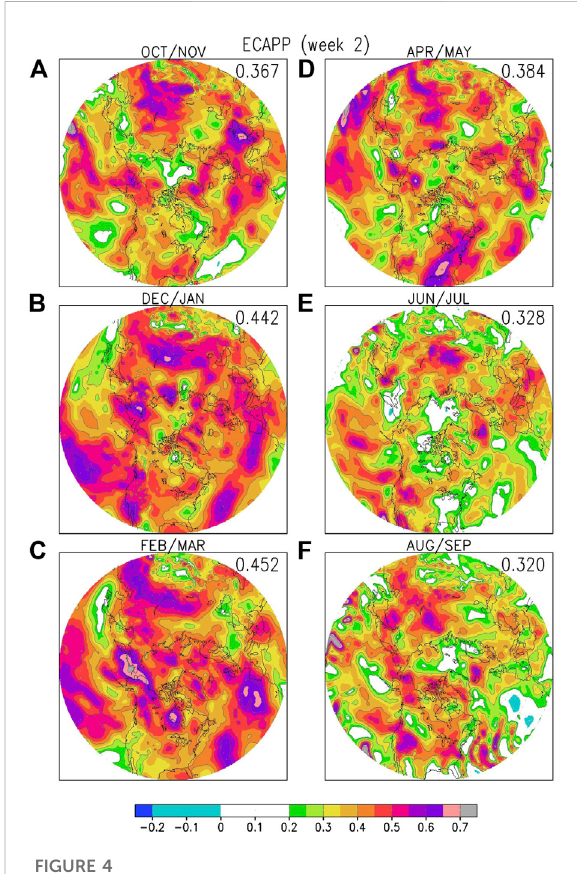
FIGURE 5 SameasFigure4,butforweeks3-4hindcastsofSLPvariance. For weeks 3-4 hindcasts, an ACC value of 0.23 is statistically signi fi cant at the 95% level, hence all shaded areas, apart from the light blue shade for small negative correlations, are statistically signi fi